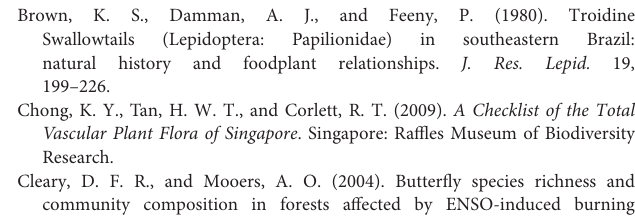
Supplementary Figure 1 | Survey locations for BW and CR butterflies divided by habitat types. Supplementary Table 1 | Source populations for Common Birdwing (BW) and Common Rose (CR) in Singapore as identified by experts, survey effort and BW and CR abundance recorded as part of our study. BW and CR prediction values represent the probability of occurrence in Singapore based on the random forest